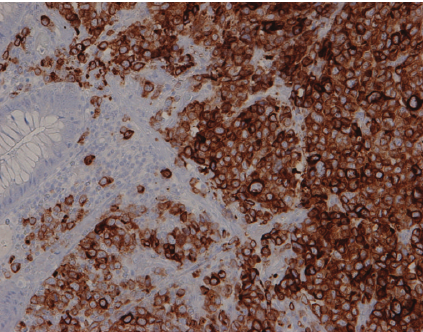
Figure4:Immunohistochemistryofbiopsytissueshowingmelan-A